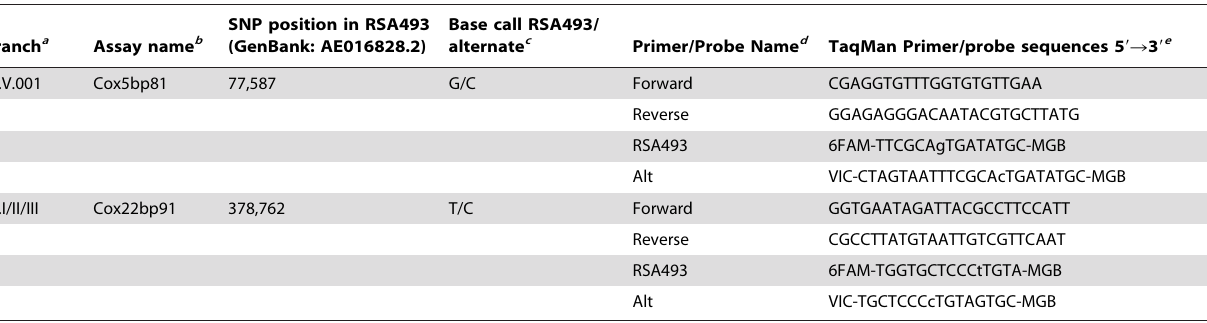
Table 2. Assay information for the two TaqMan minor-groove binding dual-probe assays used in this study.